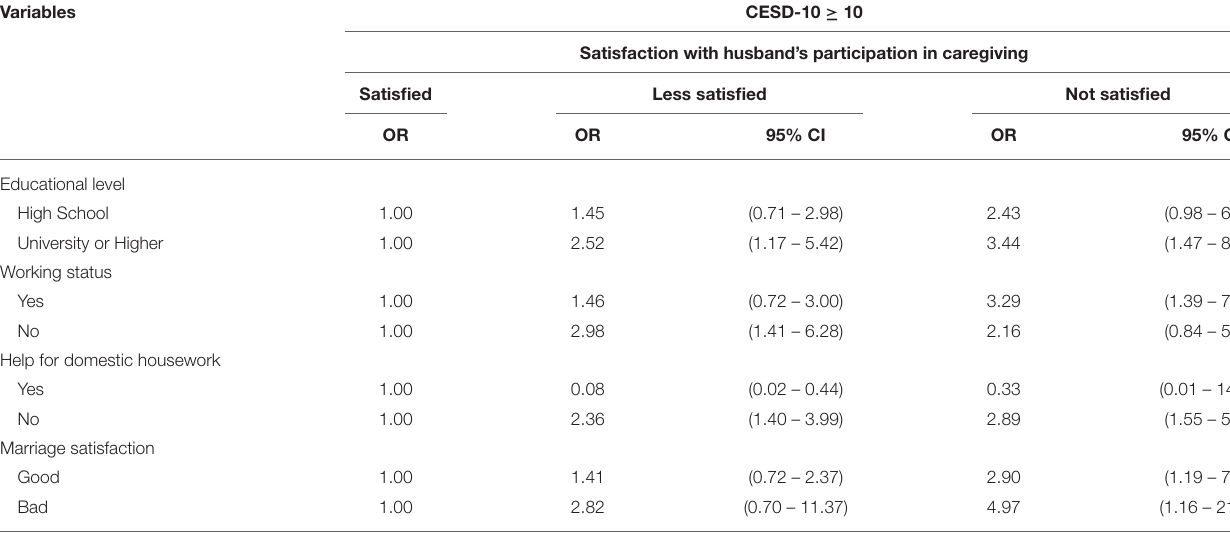
TABLE 3 | Subgroup analysis stratified by independent